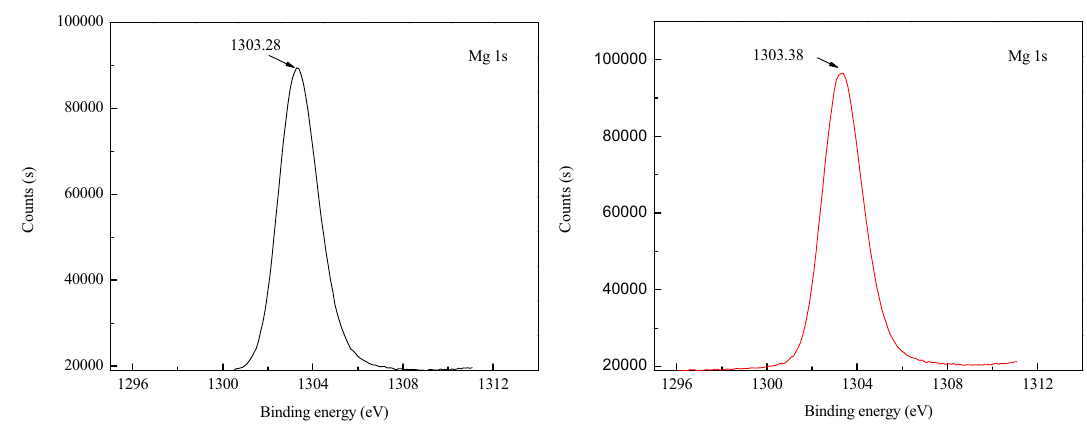
Figure 14. XPS spectra Mg (1s) of Serpentine in the absence and presence of